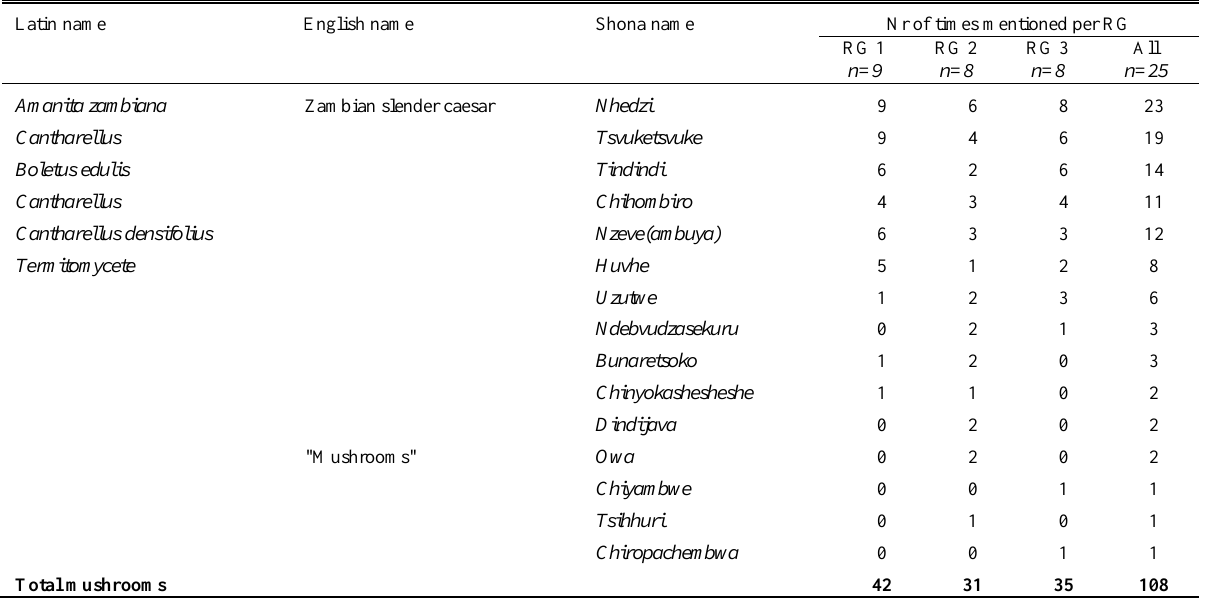
Table A3.3: Wild mushrooms, species names and collection